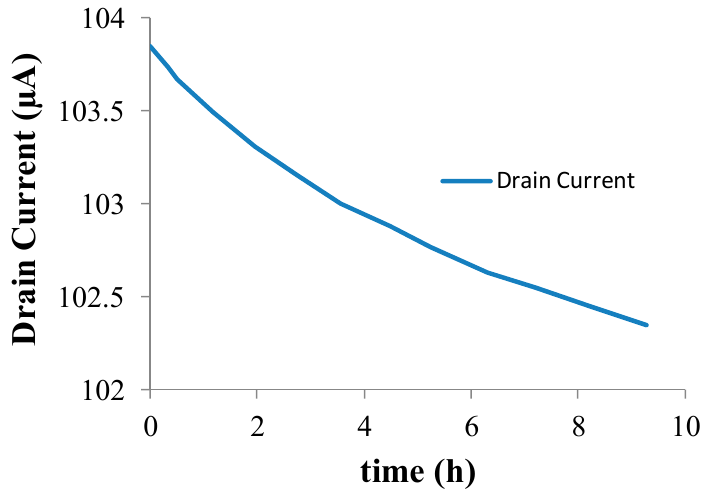
Figure 1. Measurement set-up for characterization of drift in the amperometric mode.